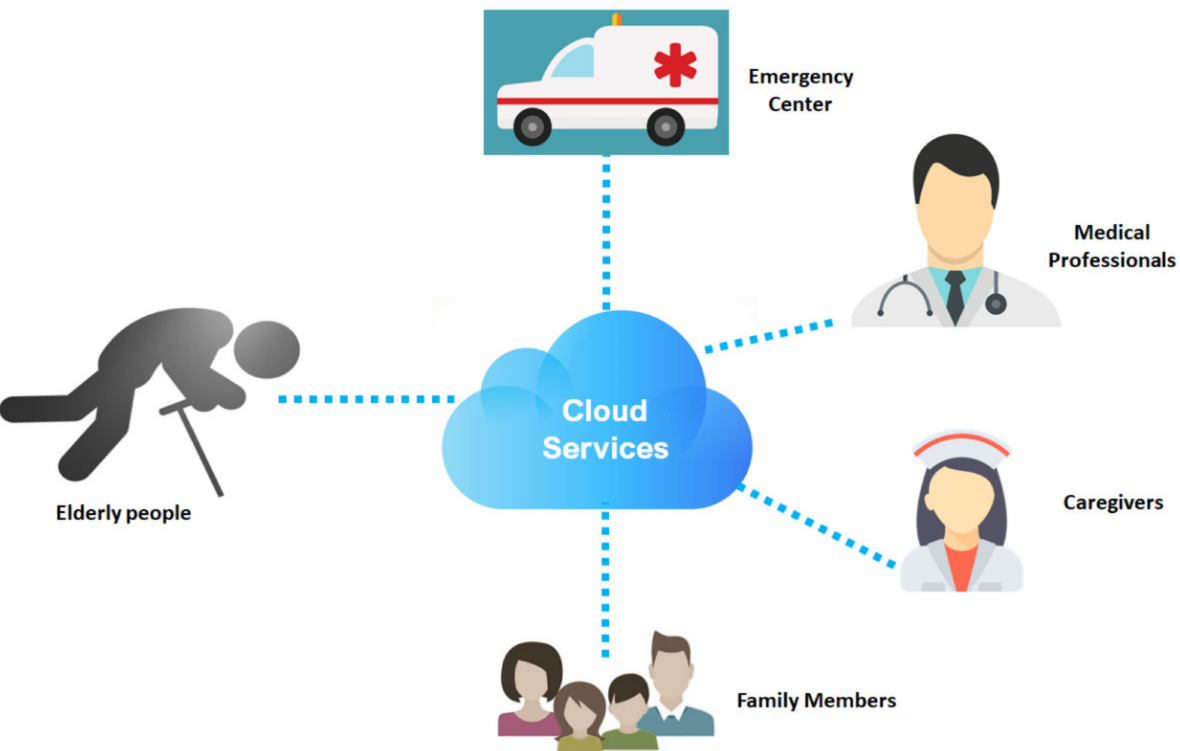
Figure 3. Fall detection system architecture general